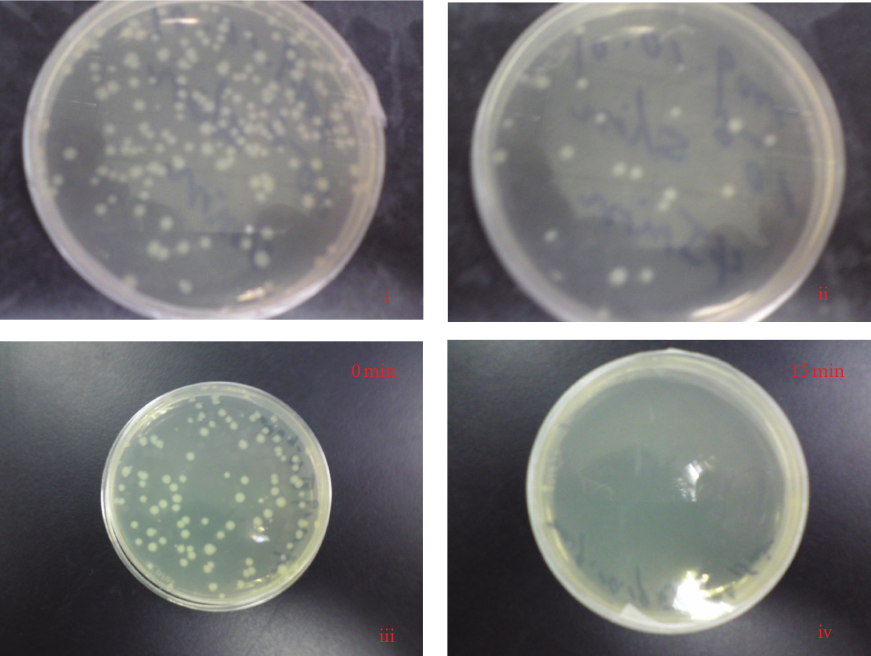
Figure 5: Inactivation e ff ect of E. coli by visible light irradiation using TiO 2 (i) (0min.) and (ii) (15min.) and Ag-TiO 2 (iii) and (iv) as photocatalysts.